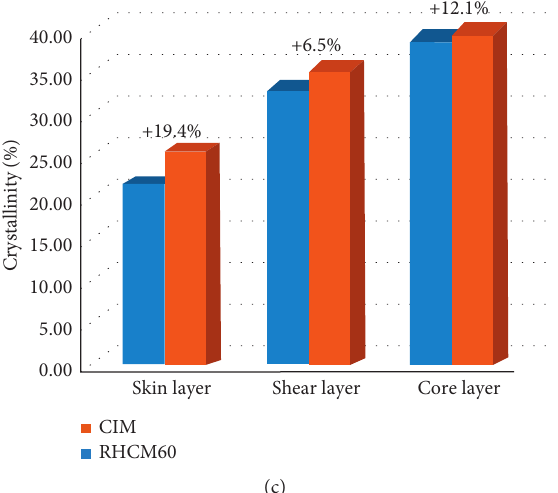
Figure 11: Comparison of microstructure layers in RHCM60 and CIM samples: (a) depth; (b) fiber orientation tensor; (c) crystallinity.